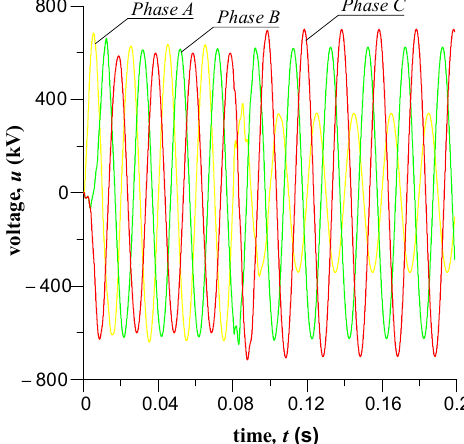
Figure 11. Phase voltage waveforms in the middle section of the line.